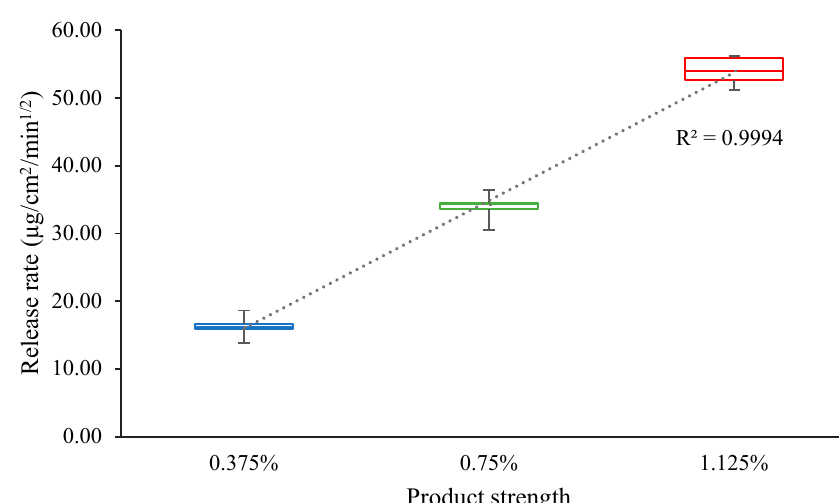
Figure 1. Box and whisker plot of the measured release rates for the three test MTZ creams, with concentrations of 0.5% (blue), 1% (green), and 1.5% (red).